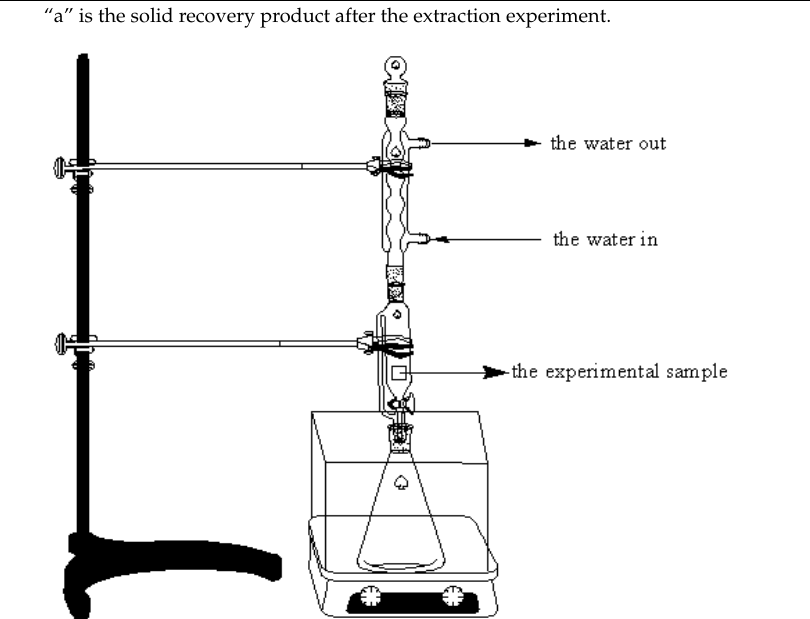
Table 2. The content of trace elements in the Mayuan Zn-Pb deposit (ppm).